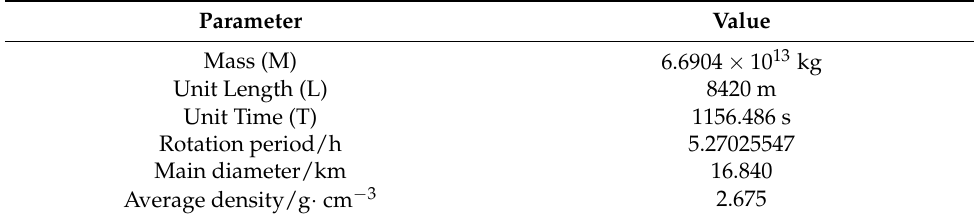
Table 2. Physical parameters of